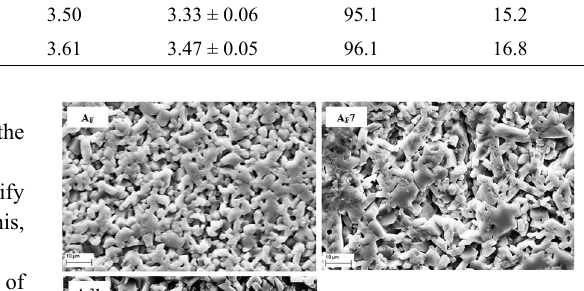
Figure 1. SEM observations of alumina A 0.92) and composites A (1,470 ºC/3 h, d